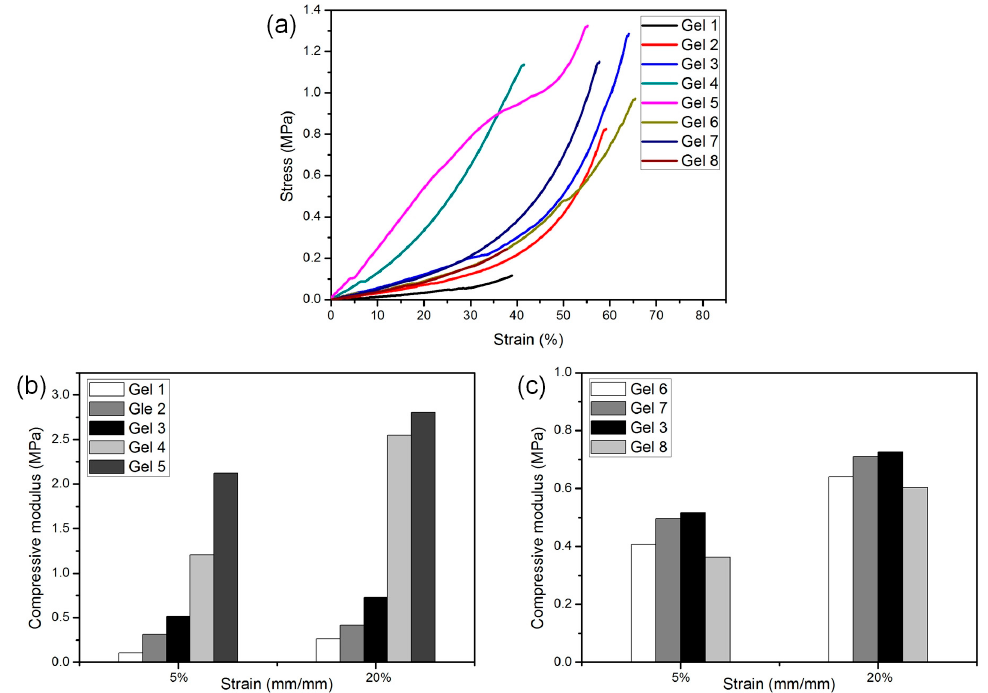
Figure 6. ( a ) Compression performance of gels: compression stress-strain curves; and ( b , c ) compressive tangent modulus at 5% strain and 20% strain.